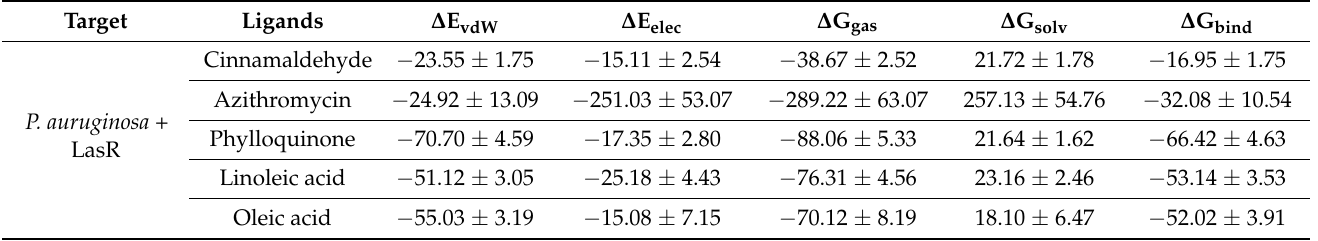
Table 7. Energy components (kcal/mol) of the top three compounds against LasR of P. aeruginosa .